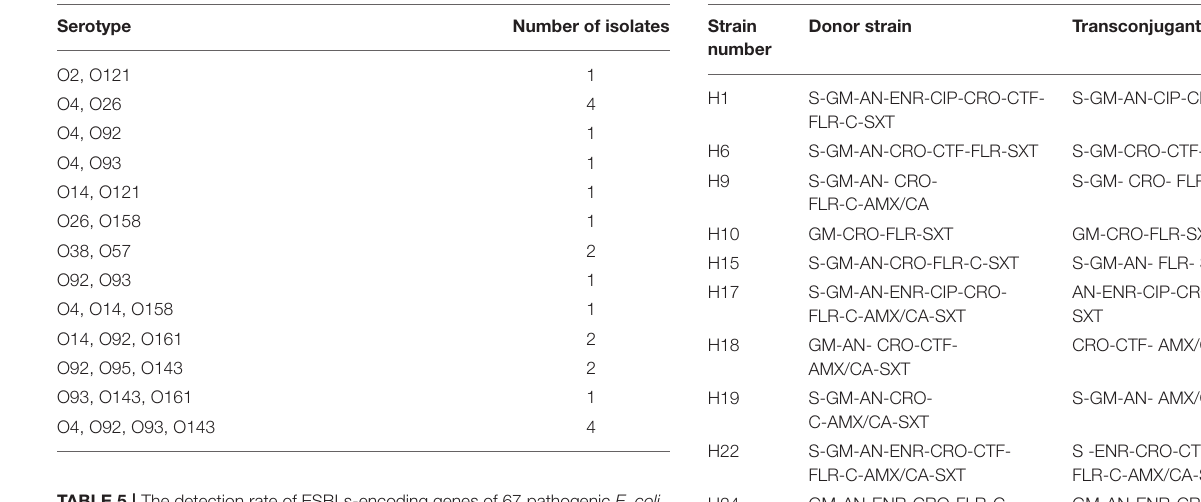
TABLE 6 | The resistance phenotype of donor isolates and